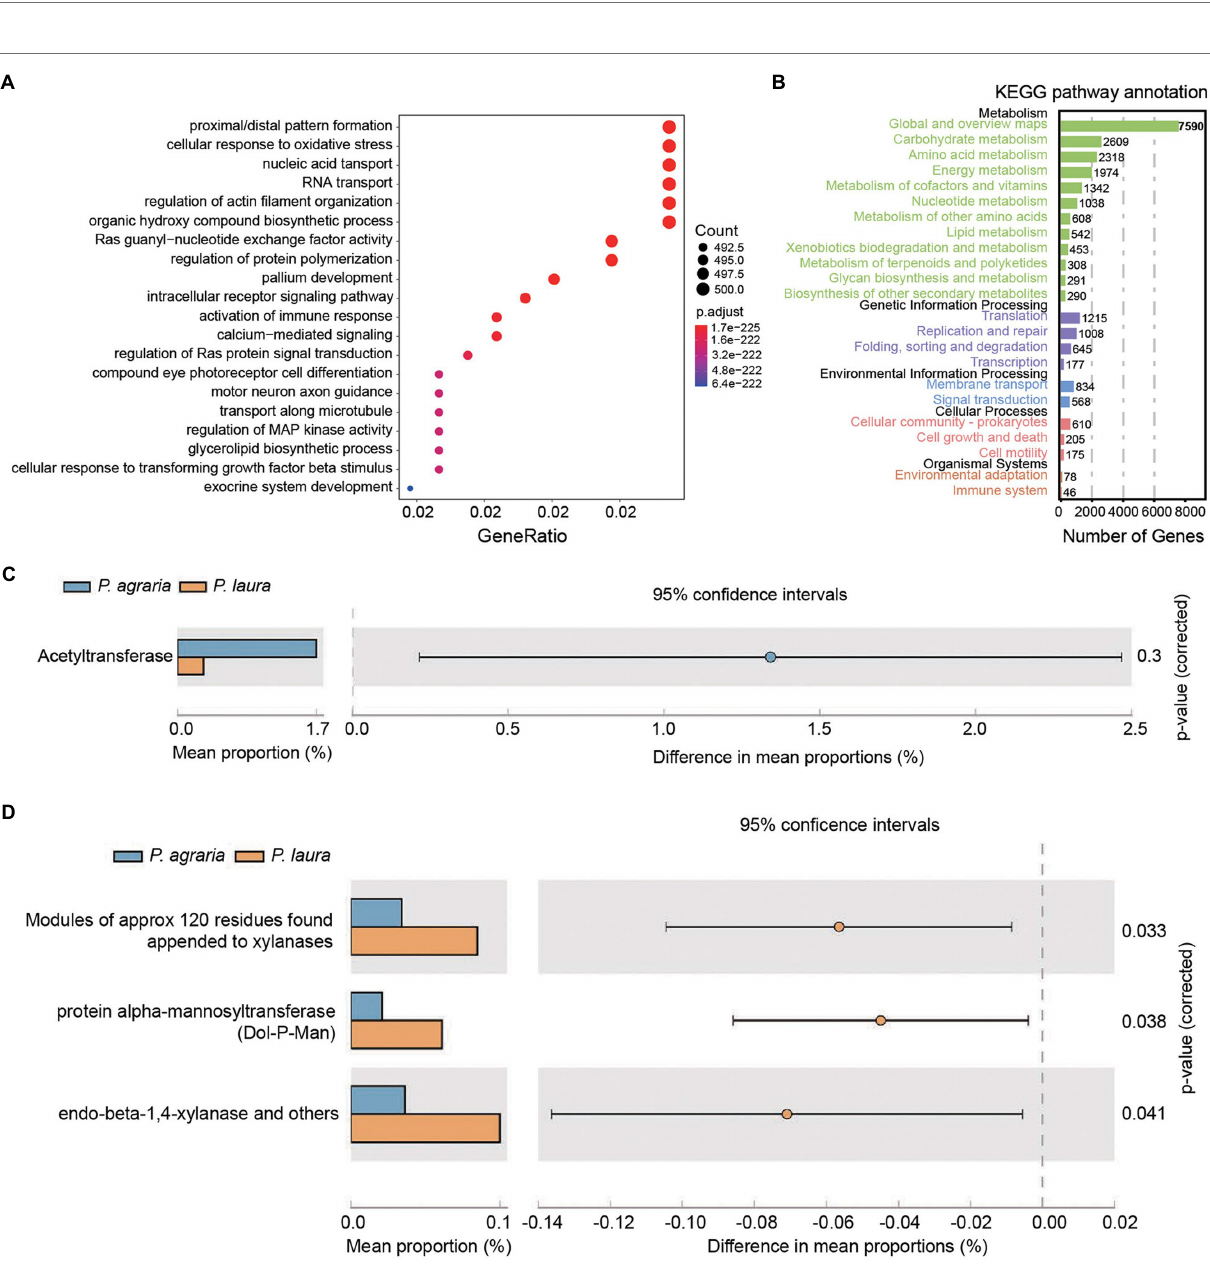
FIGURE 4 | Functional annotation of the genes in gut bacteria of the two Pardosa species. (A) Genes that mapped to the COG category were annotated using eggnog. Top 20 of the categorized functional annotation enrichment predicted in the bubble chart. The size of the circle indicates the number of genes and the color represents the significance. (B) Kyoto Encyclopedia of Genes and Genomes functional category analysis was done using GhostKOALA. Rows indicate the number of genes annotated to the corresponding B-level pathway, columns in black font are the name of the classification. (C) Comparison of antibiotic resistance- associated genes in the two Pardosa species based on the resfam database. (D) Comparison of carbohydrate metabolism-associated genes in the two Pardosa species based on the carbohydrate-active enzyme